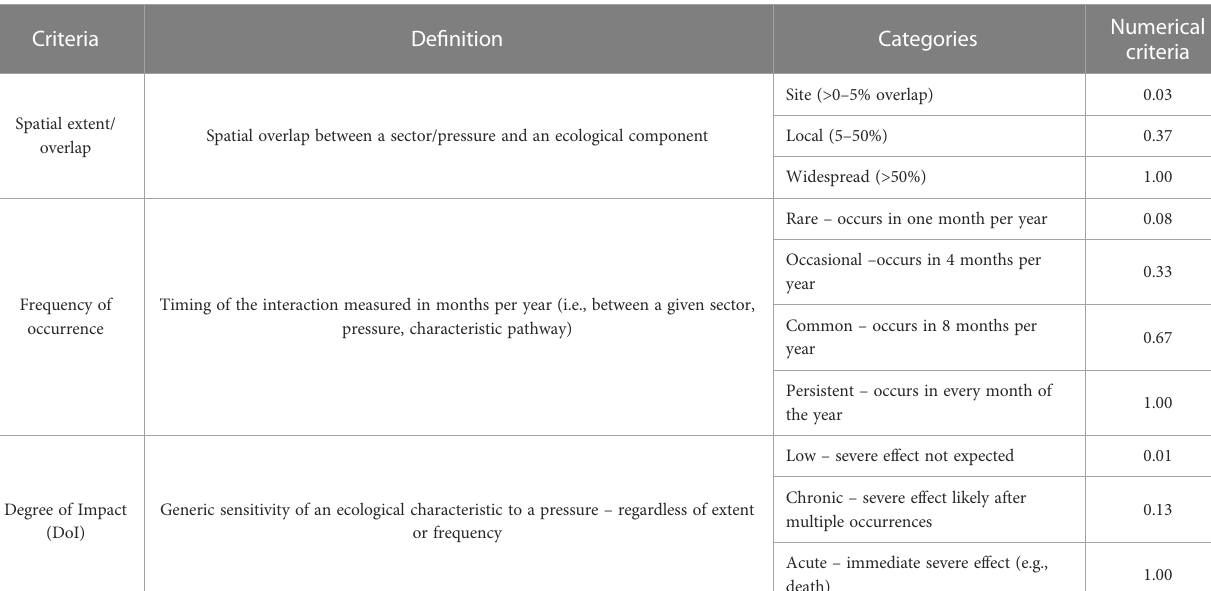
TABLE 3 Description of methodology used for Scoring